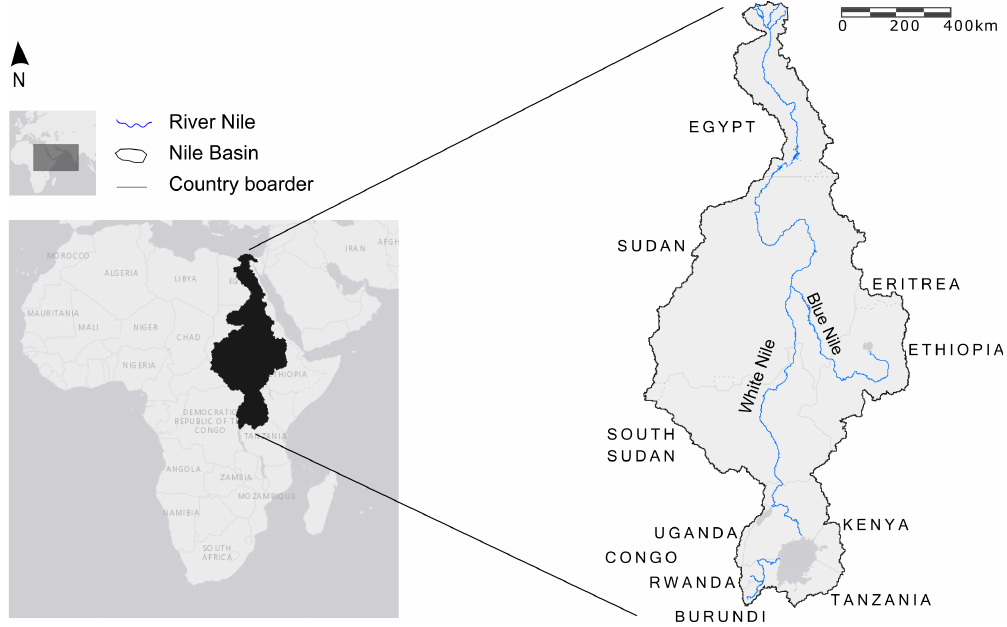
Figure 1. Nile River basin, its location and